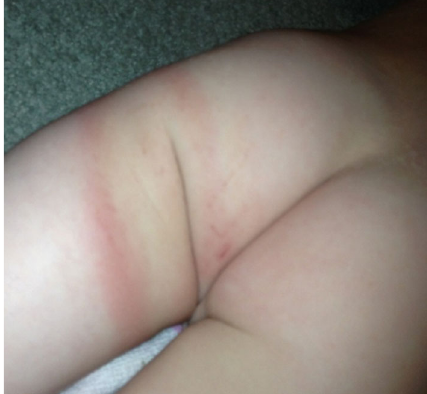
Figure 2: The classic “ bull ’ s-eye ” rash or erythema migrans of Lyme disease initially mistaken for a thigh bruise of suspected child